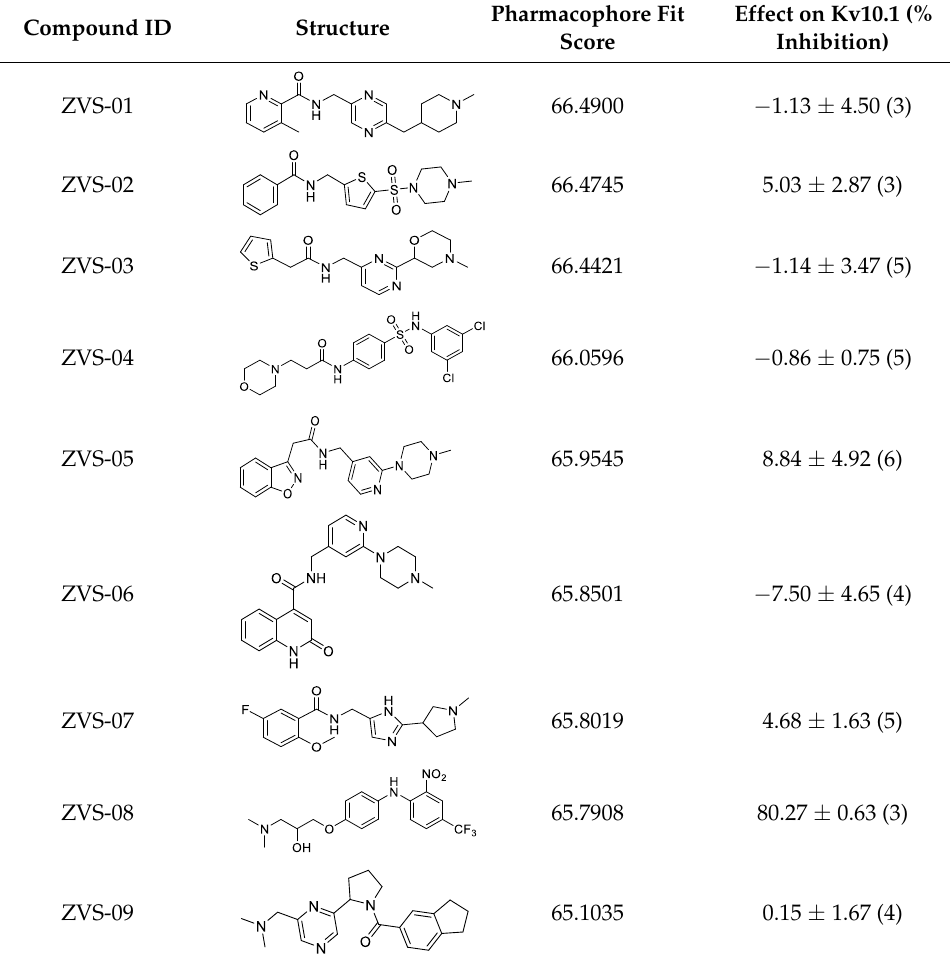
Table 1. List of screening compounds with pharmacophore fit scores and activity on K V 10.1 at compound concentration of 50 µ M.